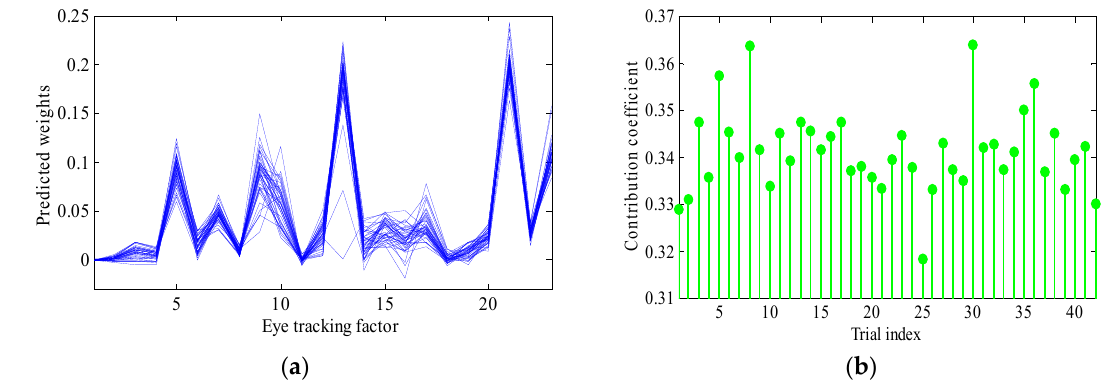
Figure 6. ( a ) Indicator contribution of all 42 trials and ( b ) contribution coefficient of trials.